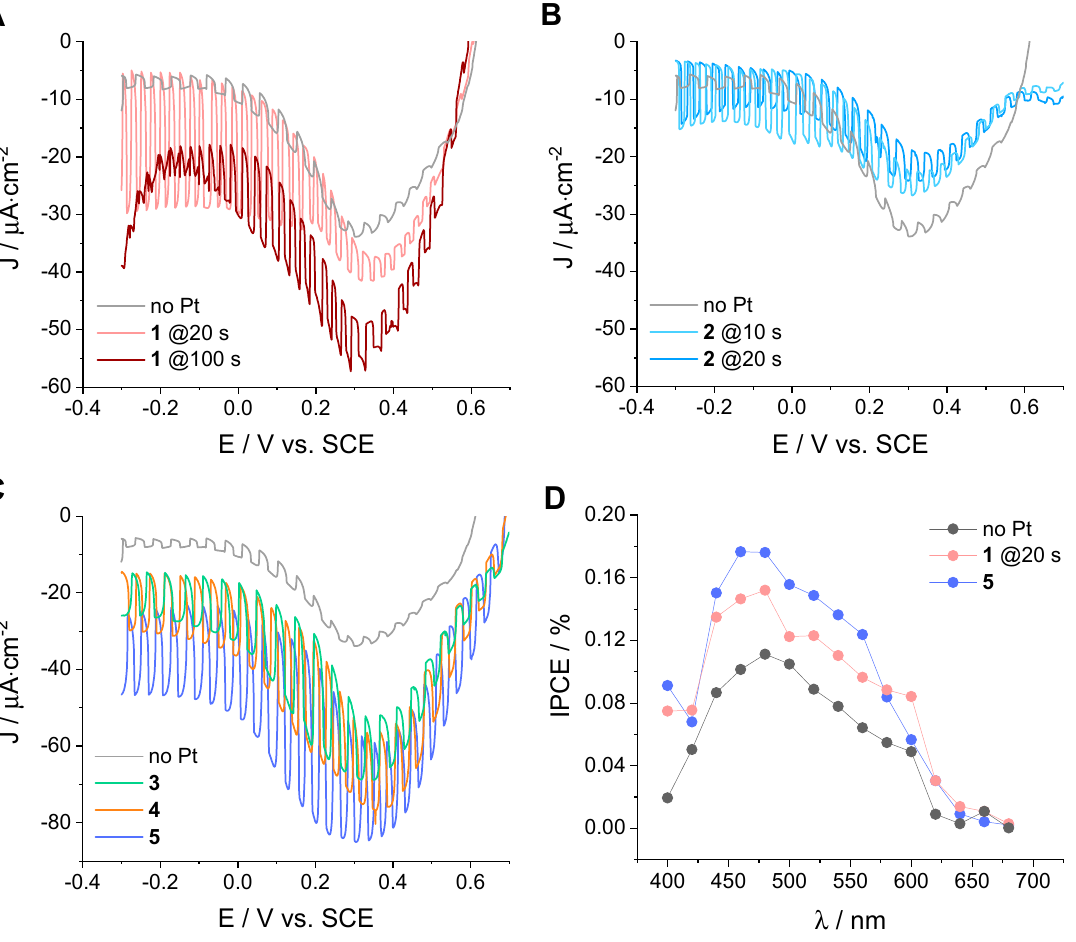
Figure 4. LSV of sensitized electrodes: ( A ) NiO-A| P1 |Pt- 1 , ( B ) NiO-A| P1 |Pt- 2 , and ( C ) NiO- A| P1 |Pt- 3–5 in N 2 -purged 0.1 M acetate buffer at pH 4 under chopped irradiation (in every graph, a comparison is made with the blank non-platinized electrode, grey trace); ( D ) photoaction spectra of NiO-A| P1 |Pt- 1 at 20 s deposition time, NiO-A| P1 |Pt- 5 , and the blank non-platinized